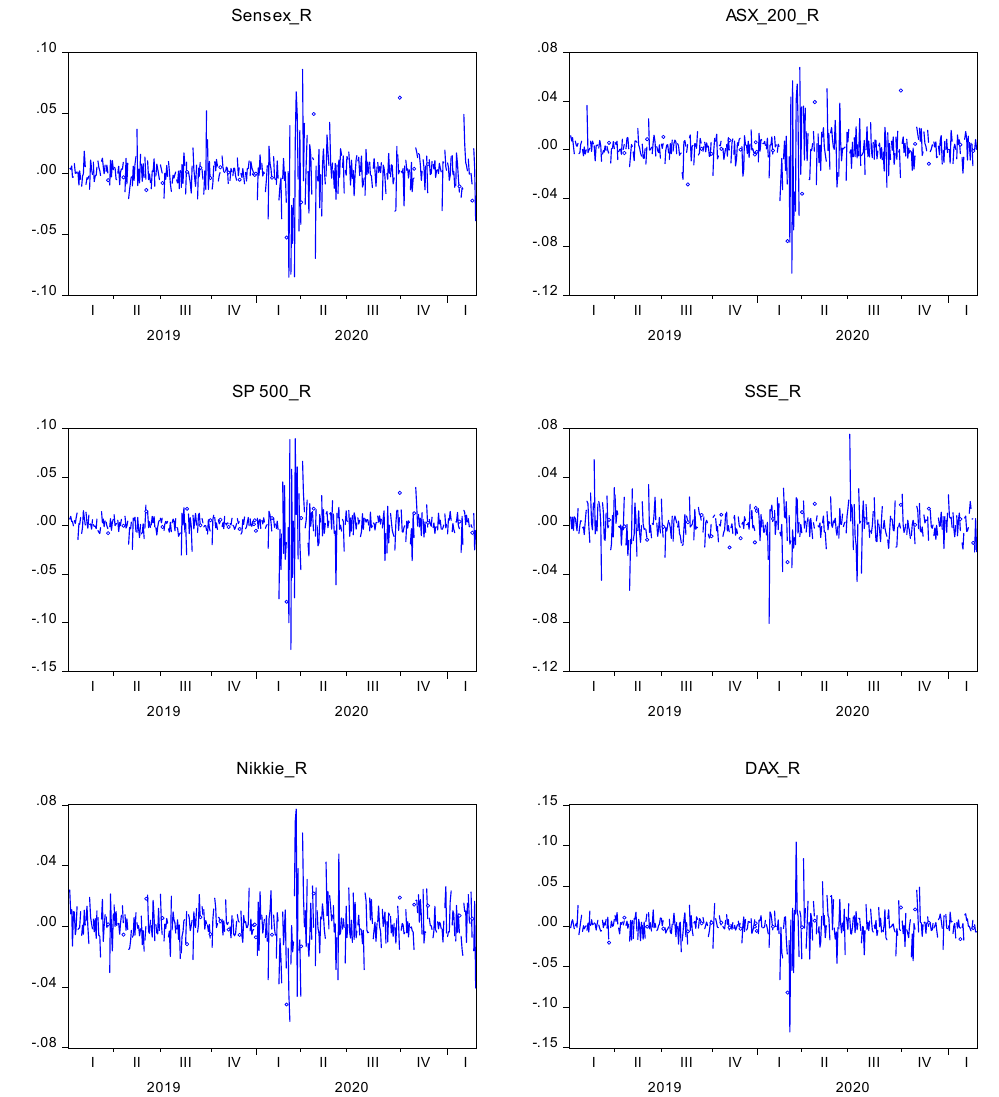
Figure 1. Time plot of Stock Market indices Log returns.